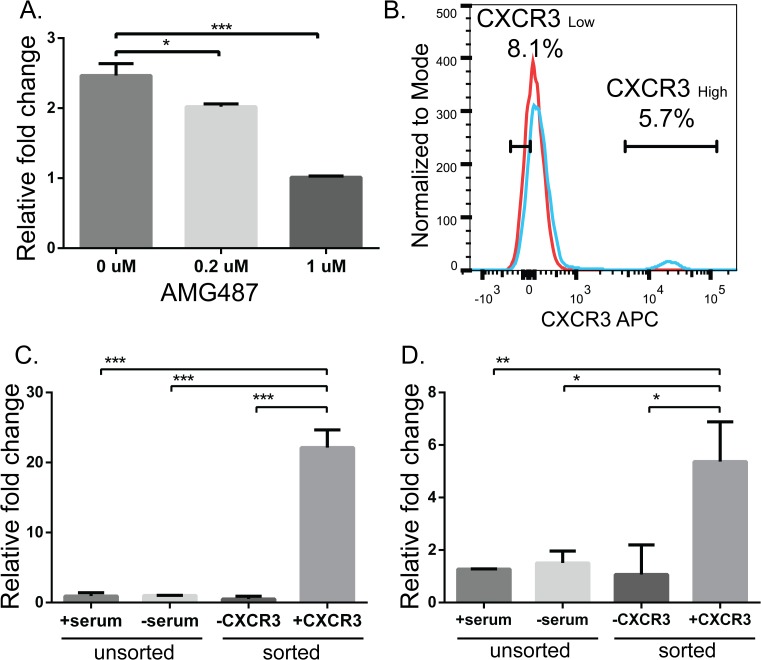
IL-8 expression in stressed BOWES cells is associated with CXCR3 signaling and increased in the CXCR3High subpopulation of cells.(A) BOWES cells were cultured for 48 hrs under stressful conditions (serum-free media at 8% CO2) in the presence of ligand (100ng/ml CXCL9 and CXCL10), with the addition of DMSO, 0.2μM, or 1μM AMG487. IL-8 expression was measured with RT-PCR, fold change was calculated relative to cells treated 1μM AMG487. (B) Flow cytometry analysis of representative data from 3 separate sorts. CXCR3Low and CXCR3High cells were sorted based on the gates shown. Red line = unstained cells, blue line = cells stained with CXCR3. (C) CXCR3 and (D) IL-8 RT-PCR results from unsorted cells grown with serum in 5% CO2 or without serum in 8% CO2 (stressed), and sorted stressed cells (CXCR3Low and CXCR3High). Fold change was calculated relative to unsorted stressed cells. T-tests were performed on the relative fold changes, pooled data from 3 separate experiments (* = P≤ 0.05, ** = P≤0.01, ***P≤ 0.001).